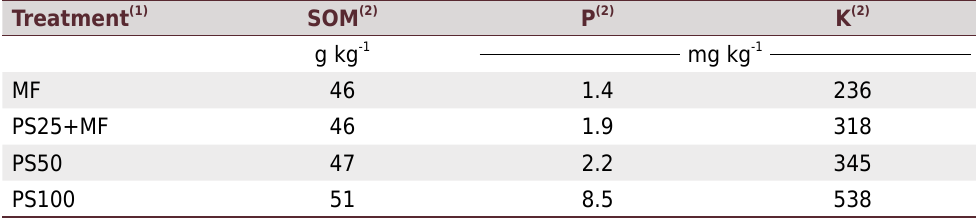
Table 5. Content of soil organic matter (SOM), available phosphorus (P) and potassium (K) in the layer of 0.00-0.20 m in a Typic Hapludox after 12 years of fertilization with pig slurry (PS), mineral fertilizer (MF) and pig slurry combined with mineral fertilizer (MF + PS) Treatment (1)